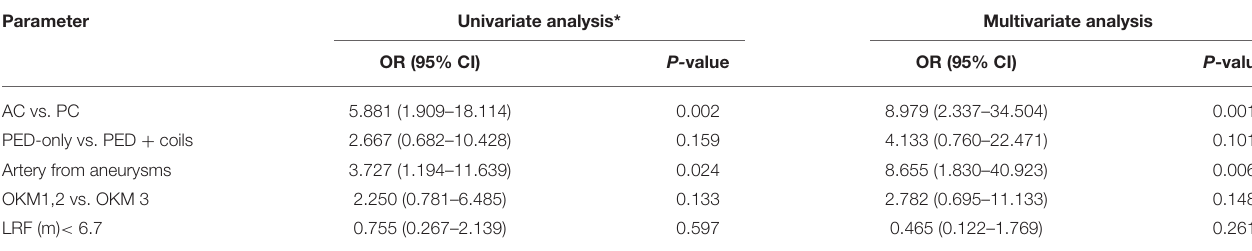
TABLE 4 | Predictors of incomplete occlusion of fusiform aneurysms treated with PEDs.